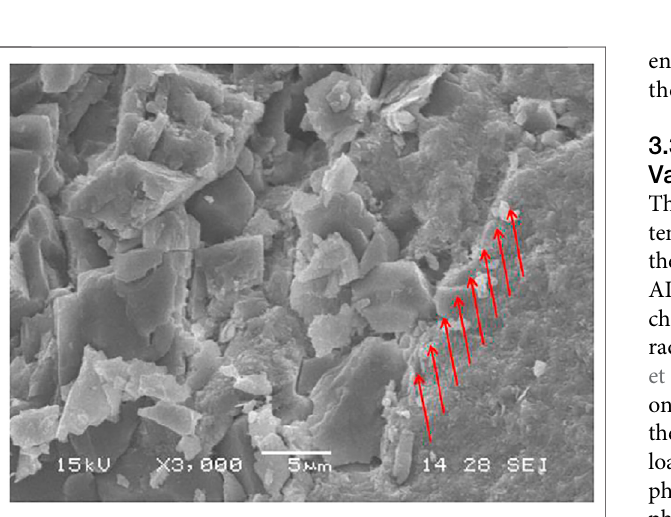
Frontiers in Earth Science |